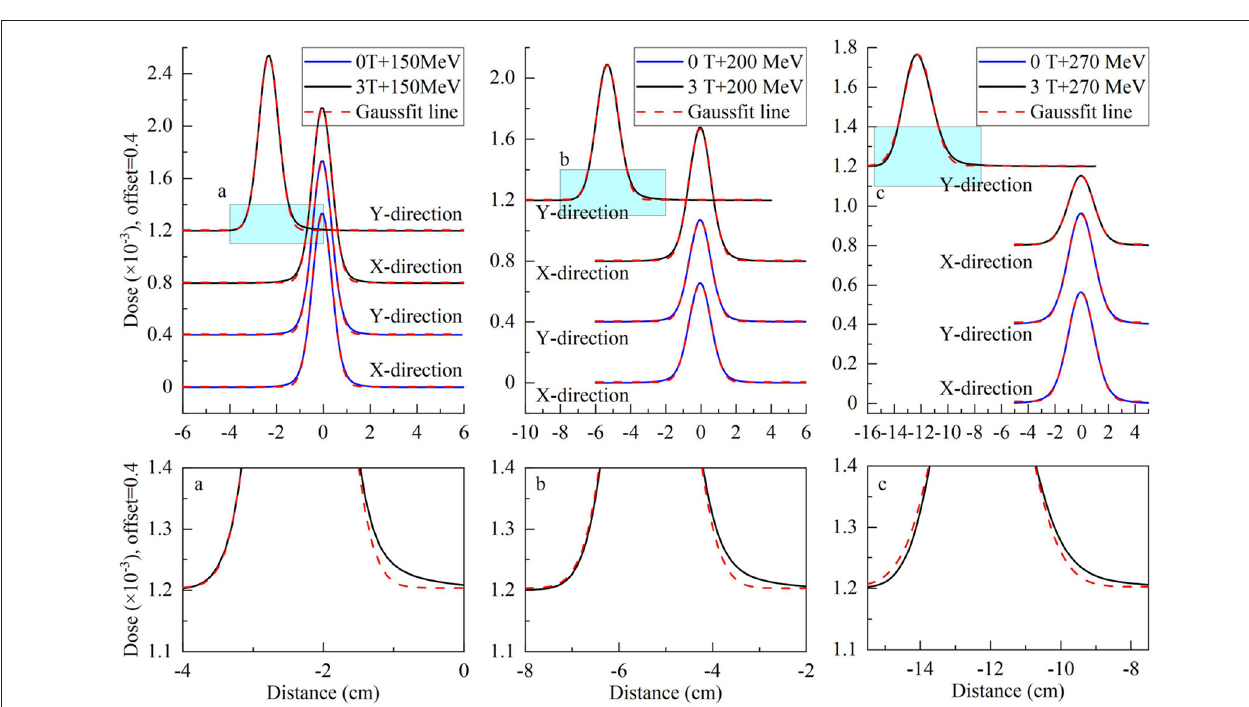
FIGURE 4 | Top panels show extracted x- transverse and y- longitudinal 1D distributions in the solid blue curve with Gaussian fit curves in the dotted red curve for 2D dose distributions in Figure 3 . Bottom panels show the detail of y- longitudinal distributions at lower dose levels.